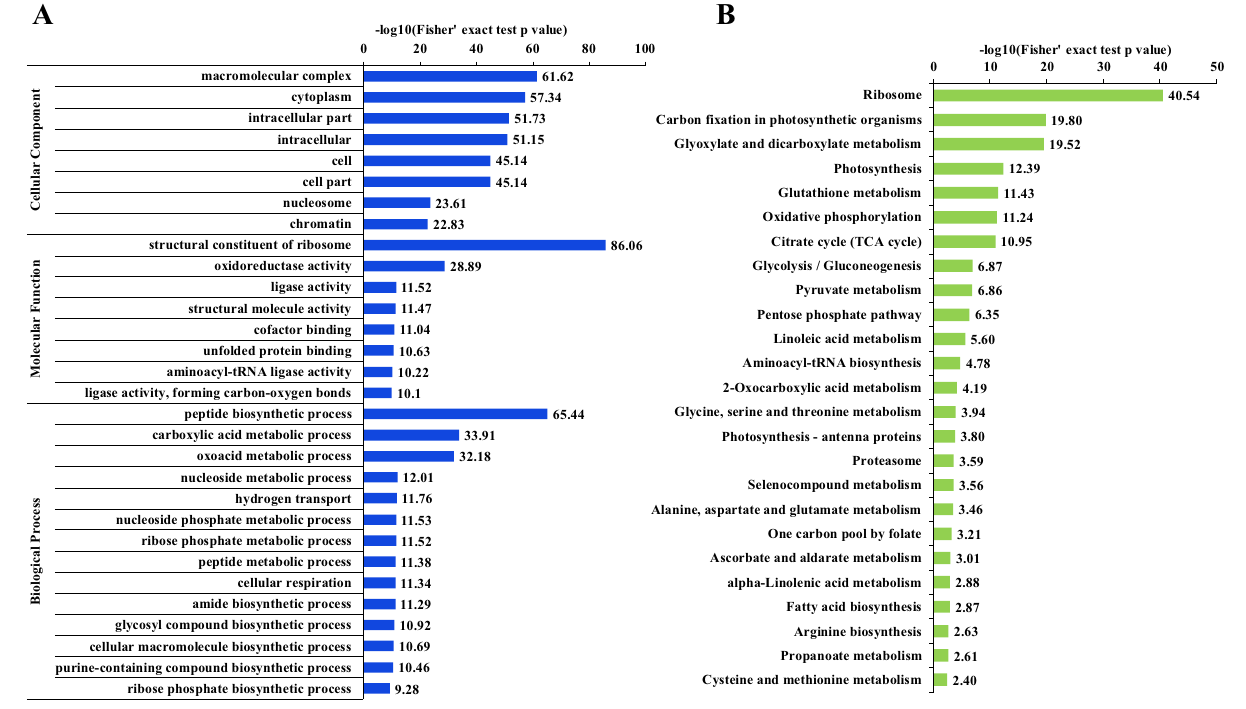
Figure 4. Enrichment analyses of the Kac proteins. ( A ) GO annotation enrichment. ( B ) KEGG pathway